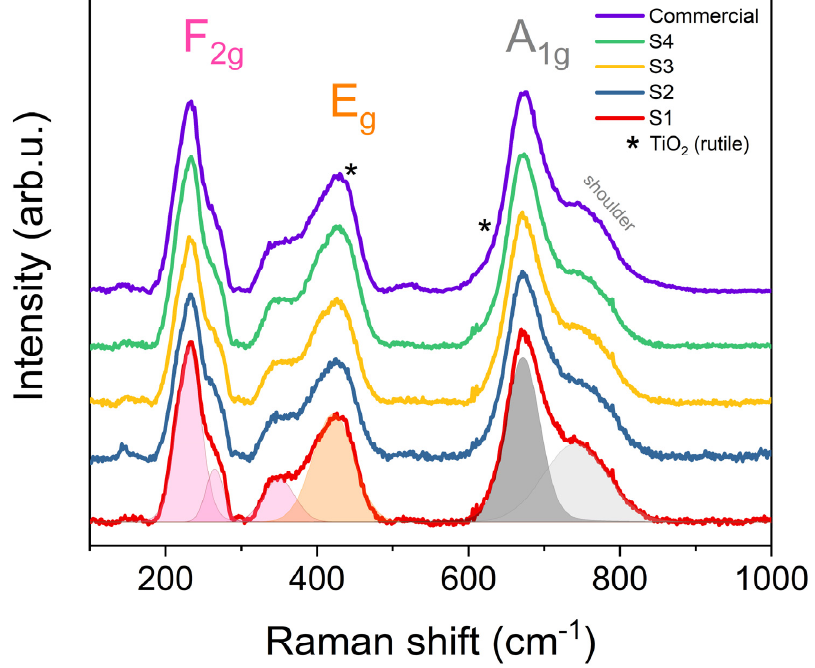
Figure 3. Raman spectra of sol–gel synthesized LTO and commercial sample (* TiO 2 rutile phase).